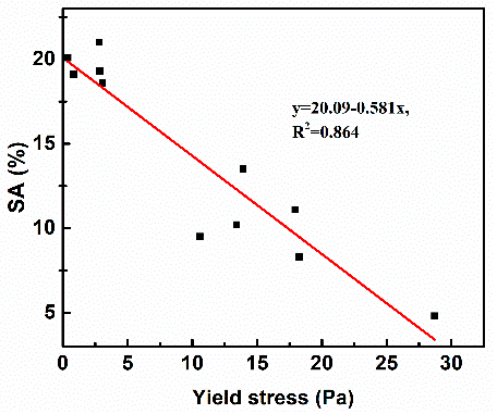
Figure 8. Relationship between yield stress and SA of SCC.